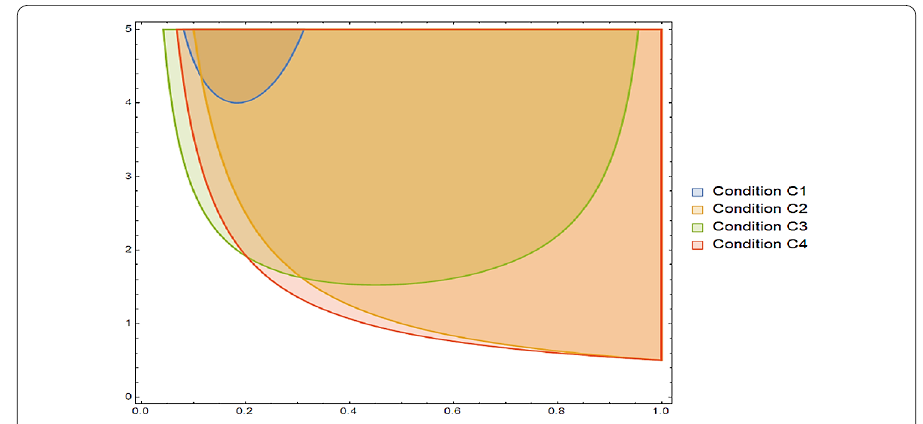
Figure 1 Regions for which Conditions (C1)–(C4) are